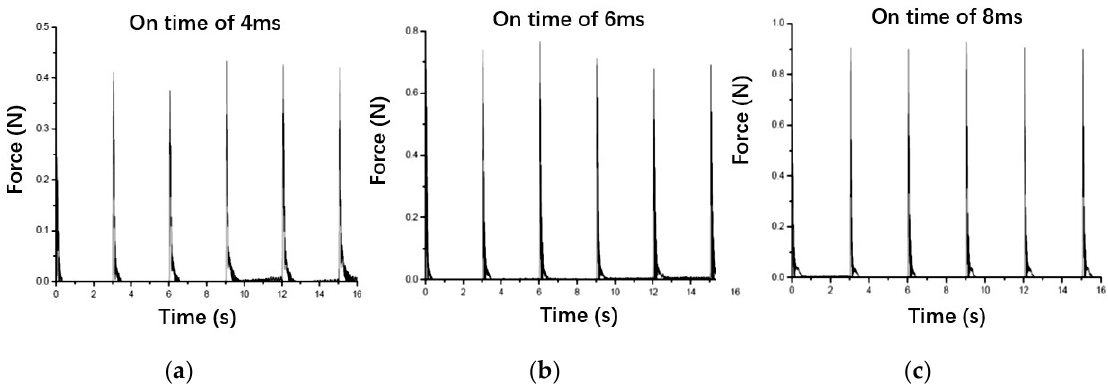
Figure 17. The short-impulse test data of a thruster at different on time commands with 1 m/s switch speed, 0.15 mm stroke, and downstream throttle layout.